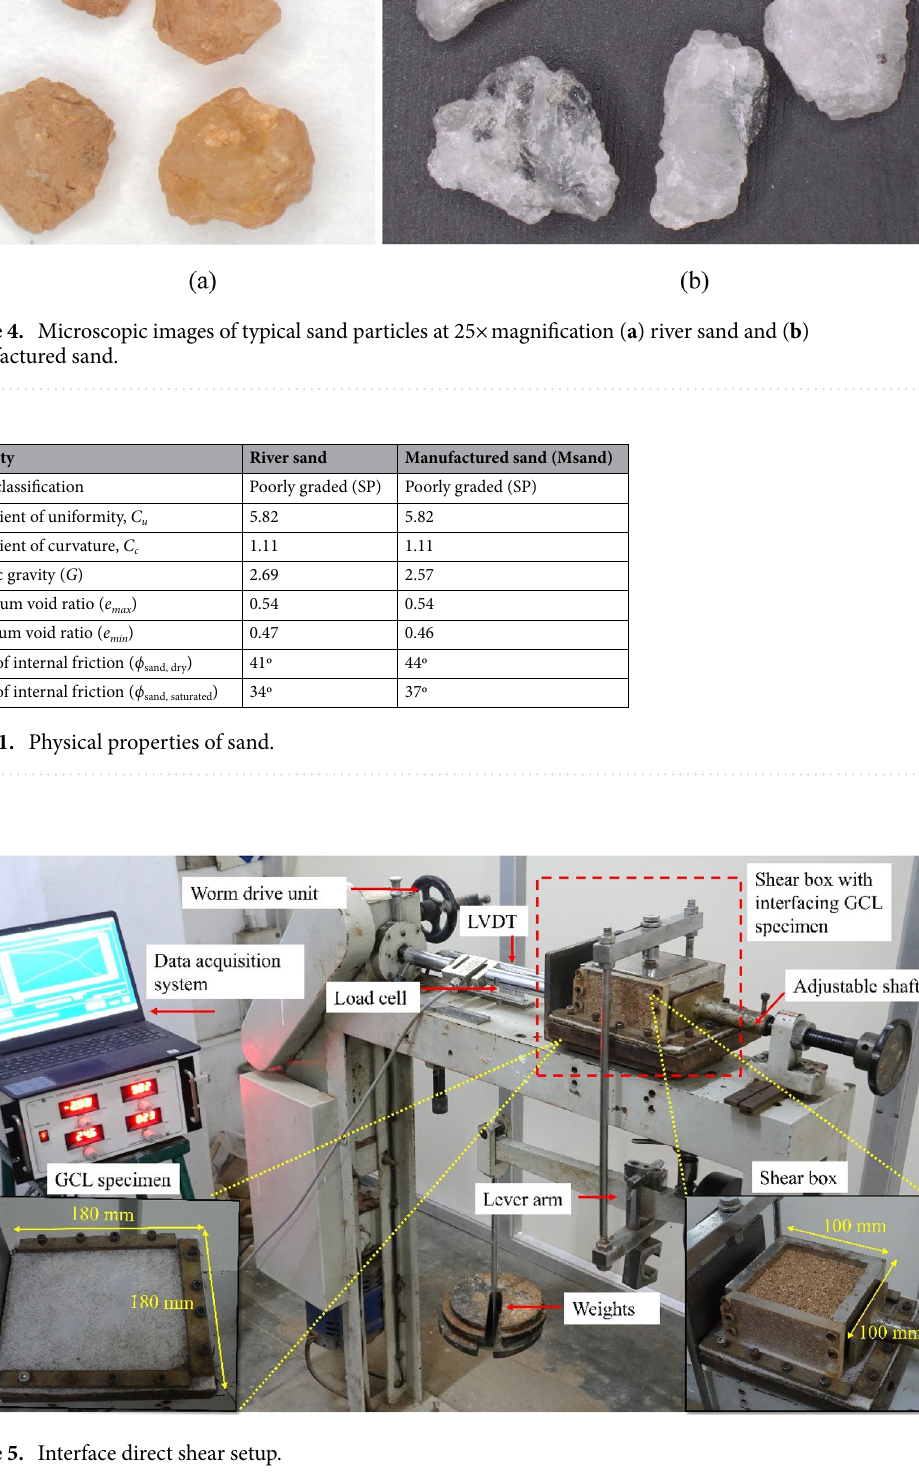
Figure 5. Interface direct shear